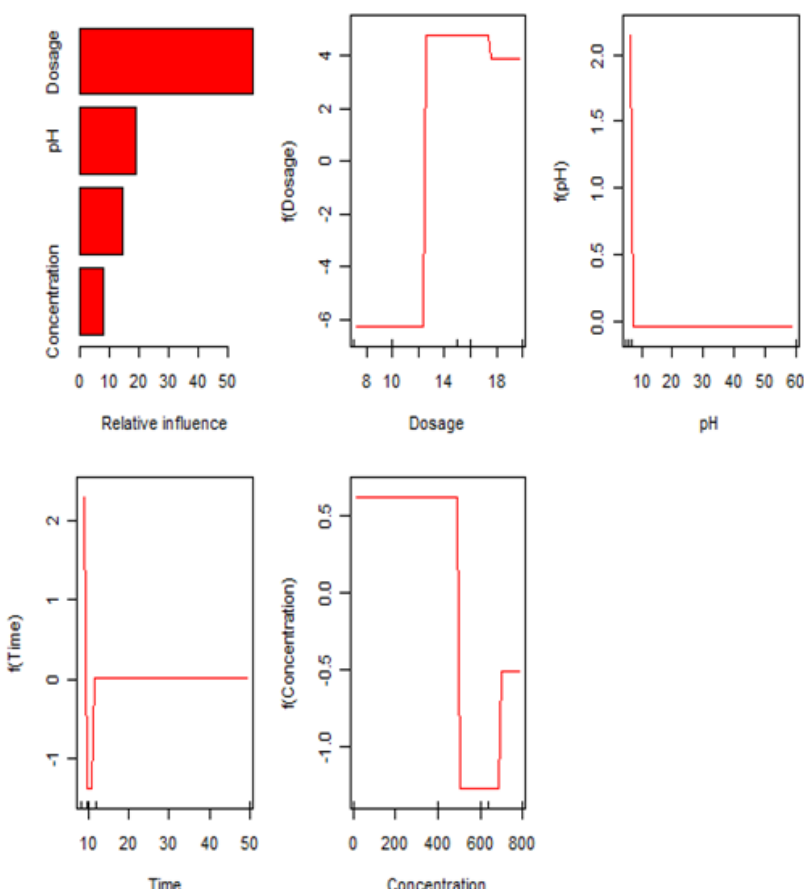
Figure 23. The relative impact of the input variables obtained by R-gui.